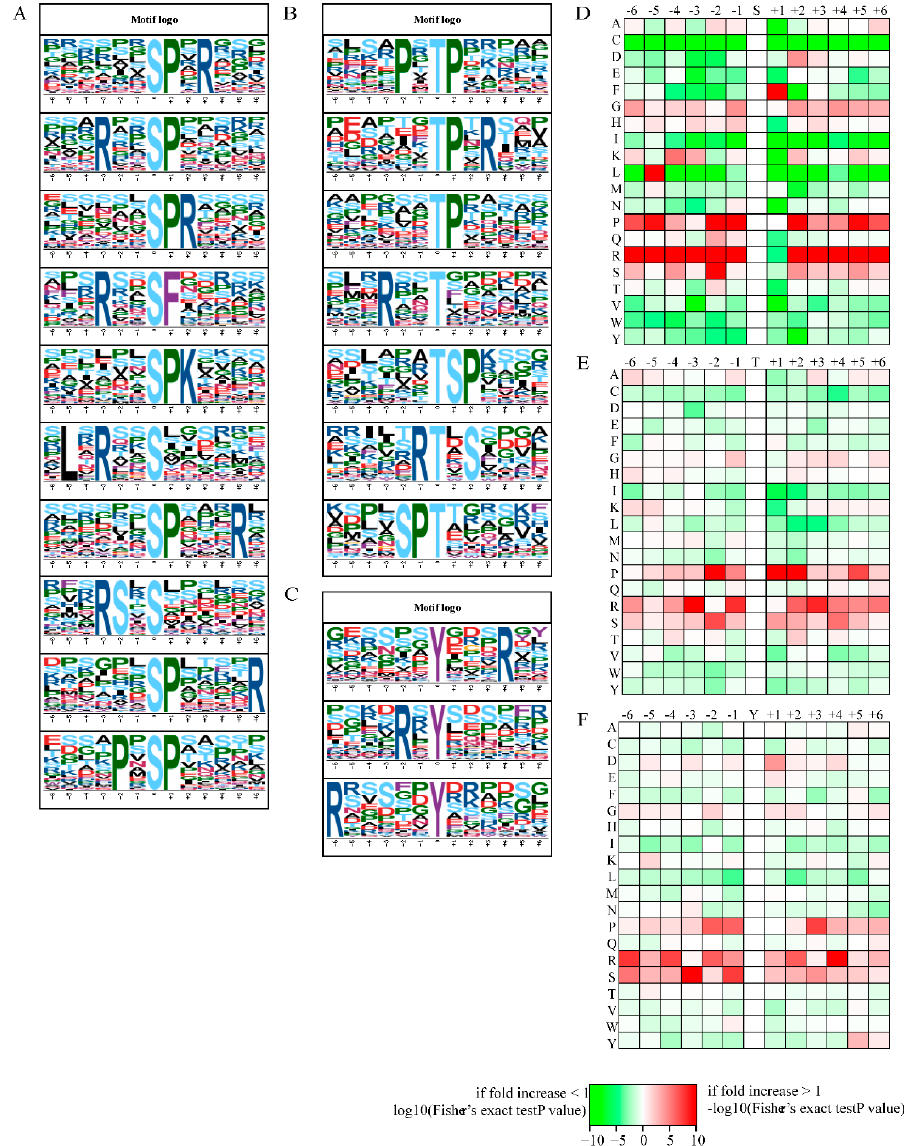
Figure 4. The motif analyses of modified sites. ( A ) Visualized motif analysis logos of serine (the top ten); ( B ) Visualized motif analysis logos of threonine; ( C ) visualized motif analysis logos of tyrosine; ( D ) conserved amino acid around the modified serine; ( E ) conserved amino acid around the modified threonine; ( F ) conserved amino acid around the modified tyrosine residues from − 6 to +6 positions.